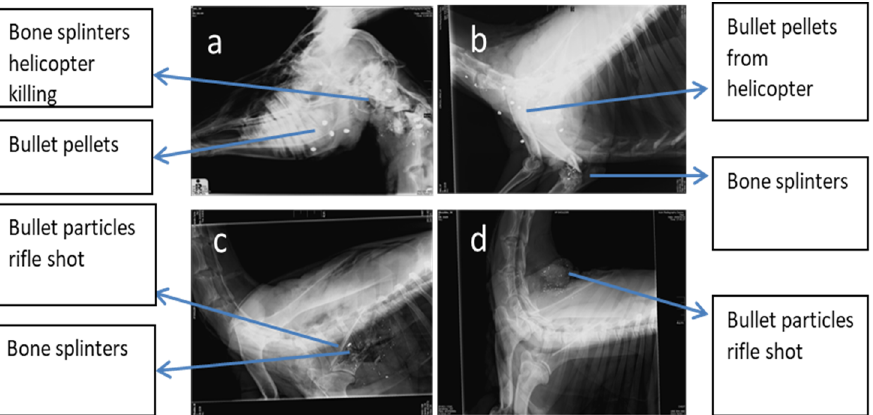
Figure 4. Helicopter head and neck shots and the distribution of pellet: ( a ) Lateral skull projection and ( b ) lateral shoulder projection. Rifle thorax cavity shots showing the distribution of bullet fragments: ( c ) lateral thoracic spine projection and ( d ) lateral cervicothoracic junction projection.